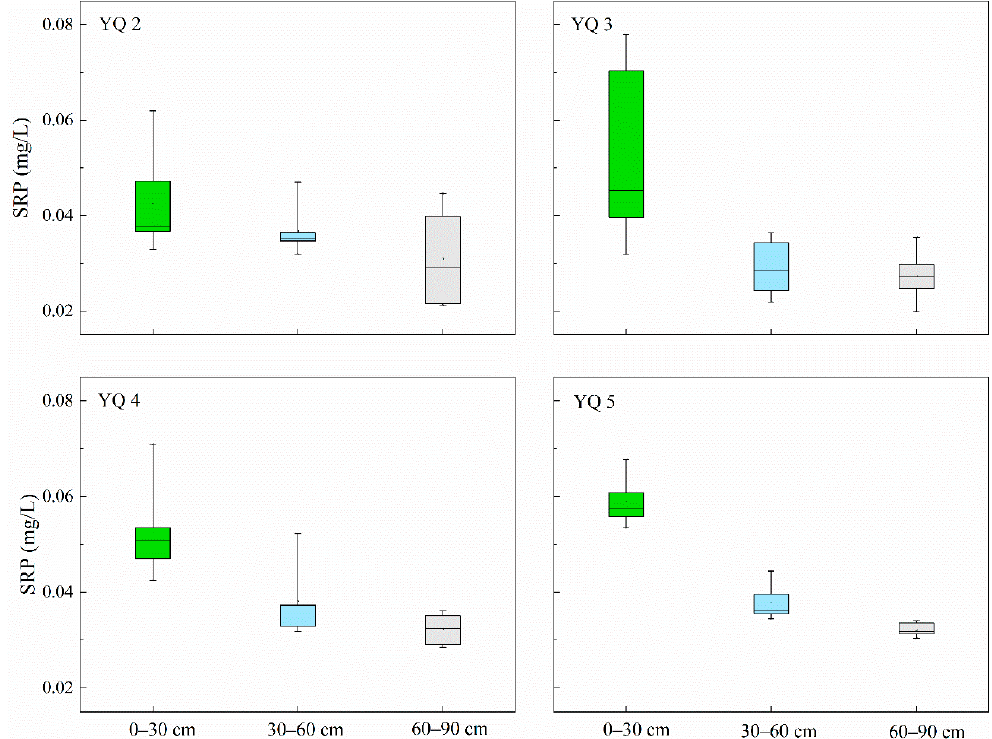
Figure 7. Boxplot for SRP concentration in ambient lake water above the sediments during the simulation of sediment release. The edges of the boxplot represent the 75th and 25th percentiles, respectively. The solid line in the box represented the median value. The branch gave the range of the data except for the outliers.